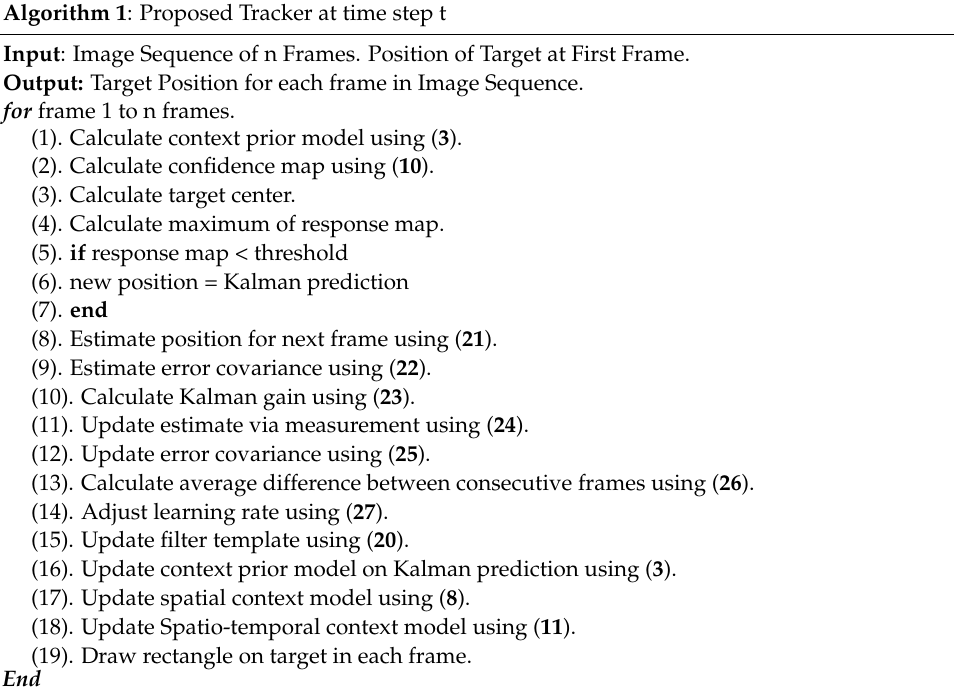
Algorithm 1 : Proposed Tracker at time step